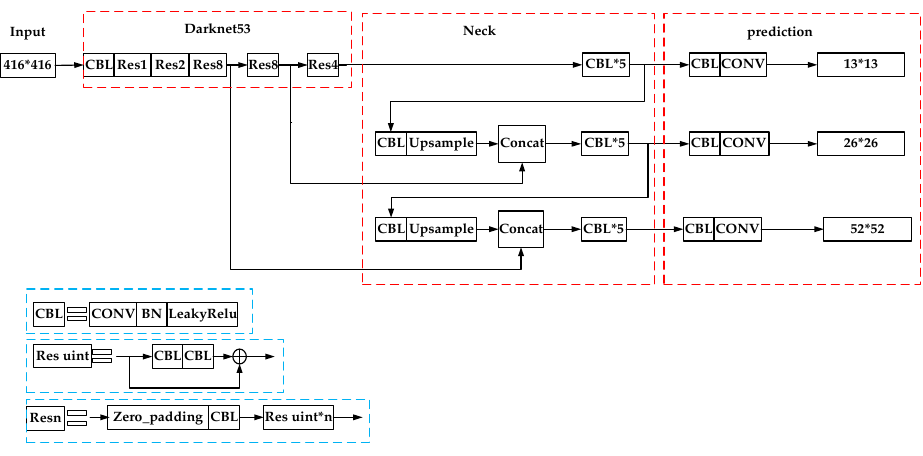
Figure 1. YOLOV3 network model.